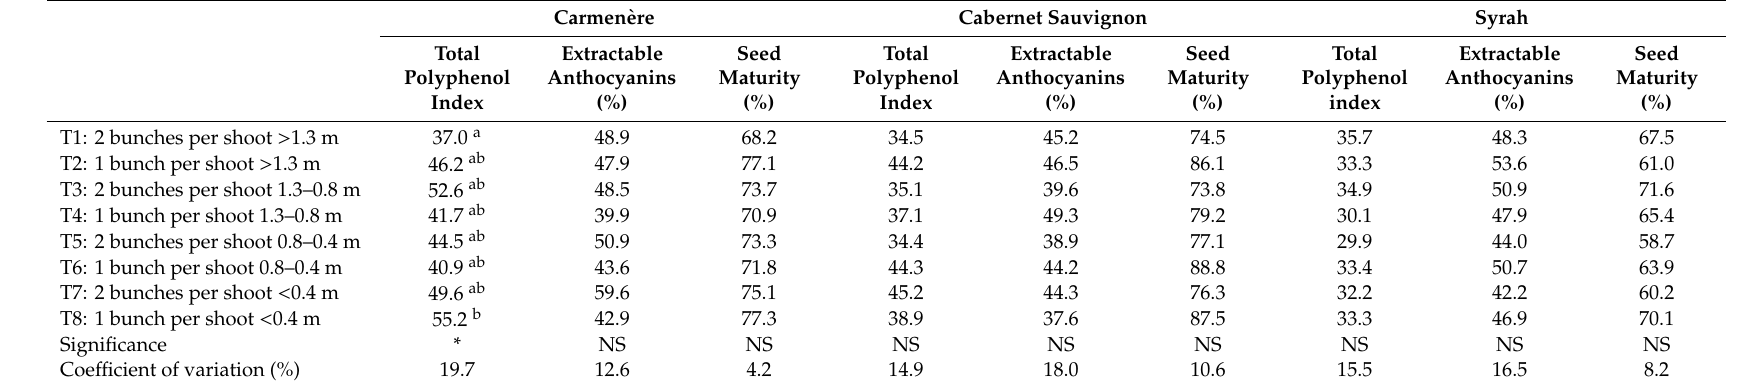
Table 5. E ff ects of the leaf-to-fruit ratios (cm 2 / g) on phenolic maturity in cv. “Carmen è re”, “Cabernet Sauvignon”, and